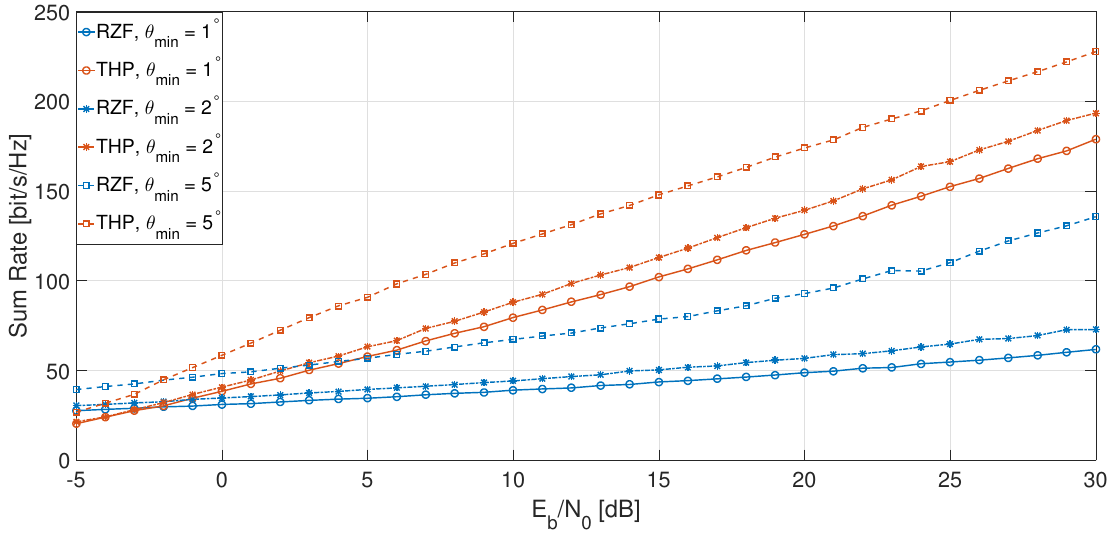
Figure 8. Sum rate vs. E b / N 0 and θ min